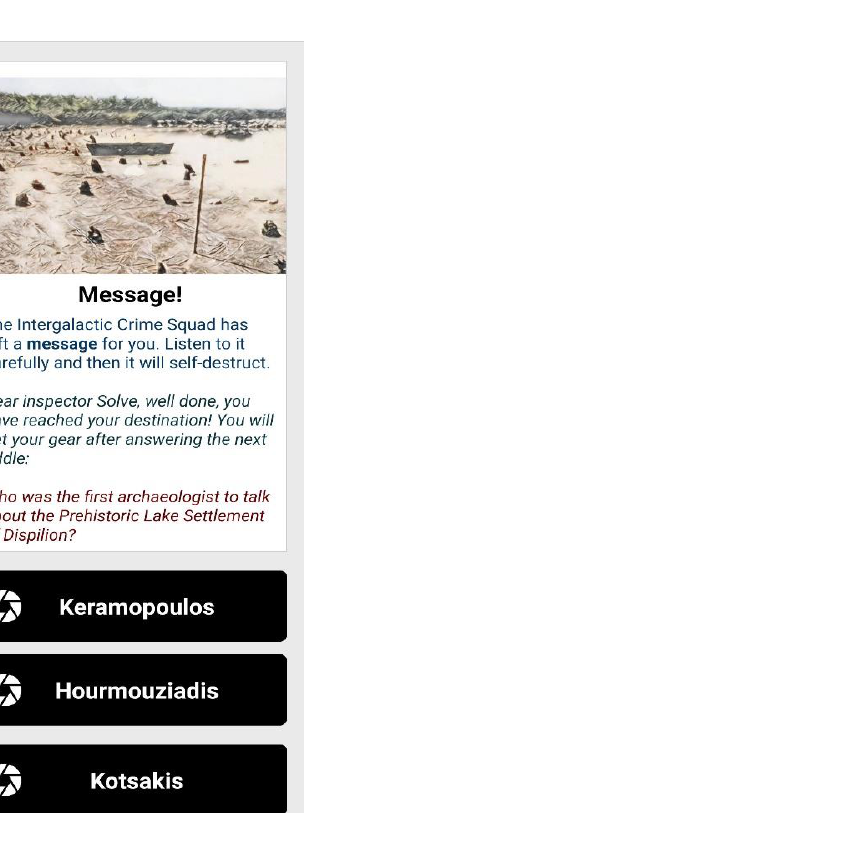
Figure 12. Game map. Red dots appear during game play, and the player has to get to the dots.